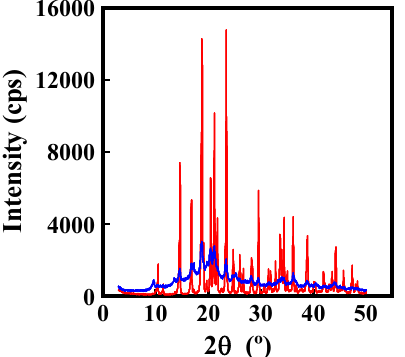
Figure 5. Powder X-ray diffractograms of spray-dried powders. Red line: mannitol; and blue line: the equal-mass mixture of mannitol and